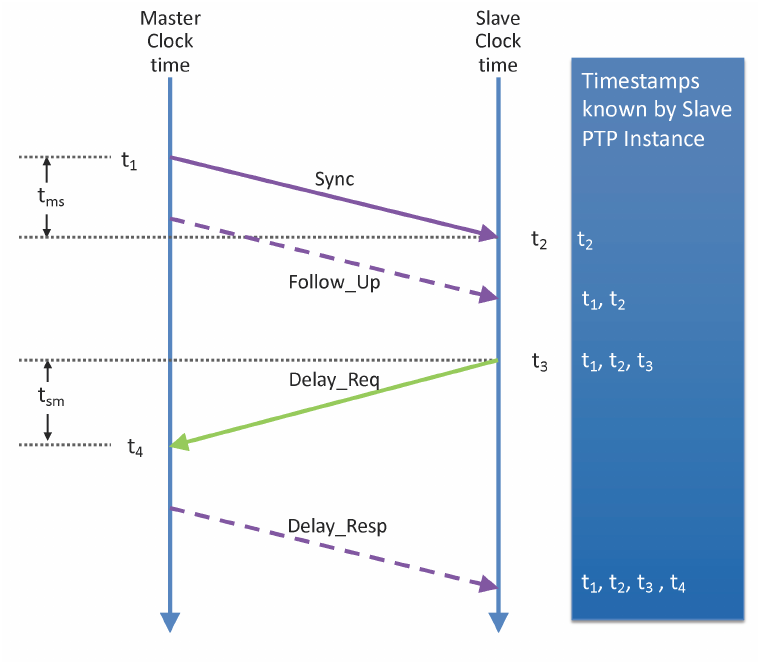
Figure 1. A message exchange providing time from a master clock to a slave clock using the PTP. Image credit: reprinted from the previous version of the IEEE 1588 time specification. Source: Adapted from